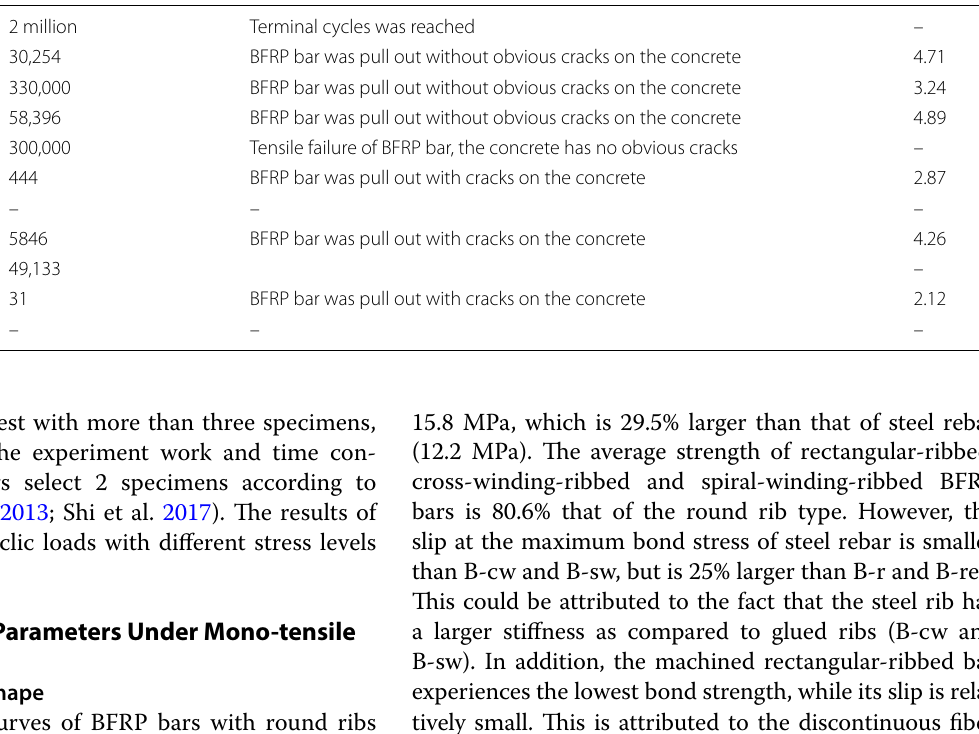
Table 5 Results of specimens under cyclic loads.